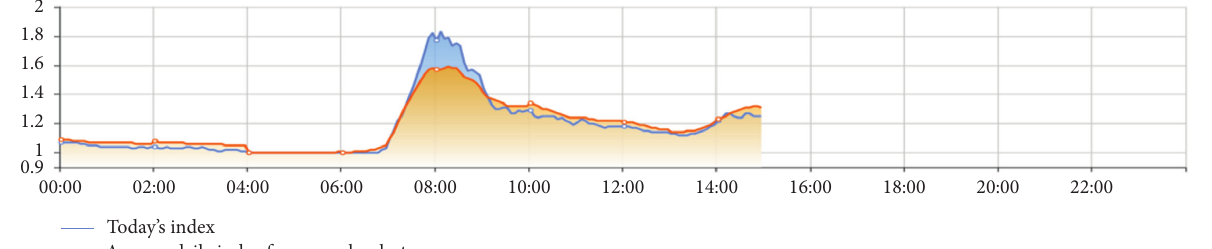
Figure 7: Real-time congestion index change.